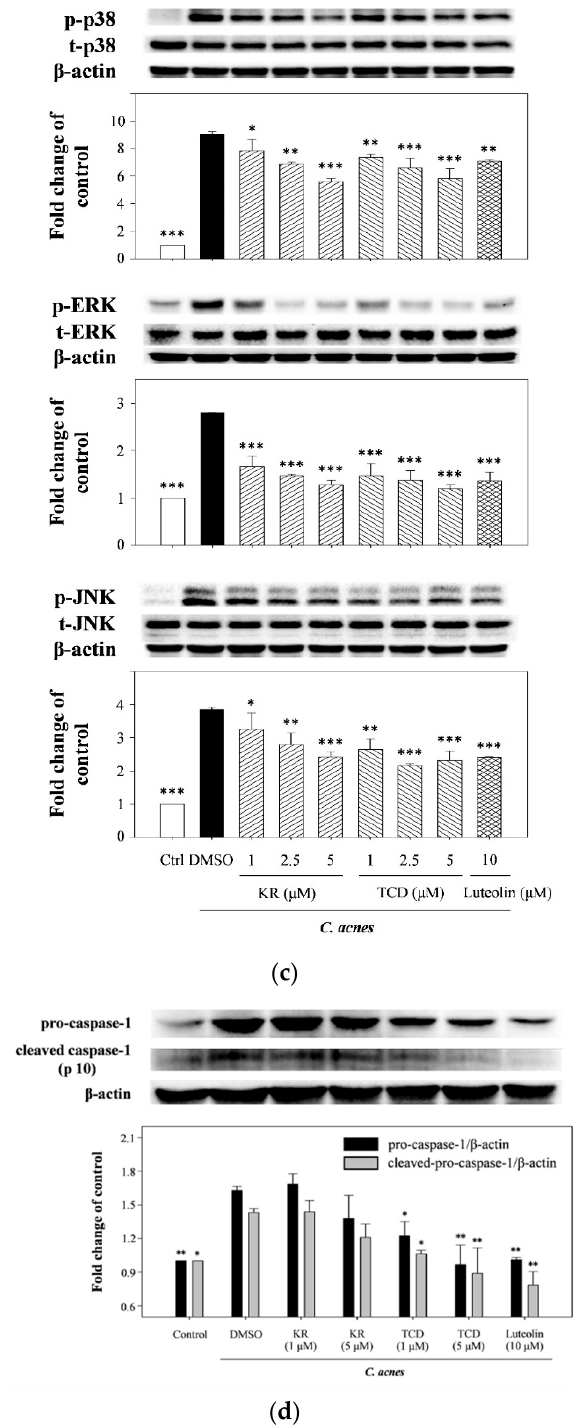
Figure 3. Effect of stimulation periods of C. acnes on activation of myeloid differentiation primary response 88 (MyD88) ( a ), and the effects of KR or TCD on MyD88 ( b ), mitogen-activated protein kinases (MAPK) ( c ), and on caspase-1 ( d ) expression. THP-1 cells were cultured with DMSO and co-incubated with C. acnes (M.O.I. = 75) for various periods of time (0, 10, 20, 30, 60, and 120 min) ( a ). To determine activation of MyD88, MAPK, and caspase-1, cells were cultured with DMSO as the negative control, or co-incubated with C. acnes (M.O.I. = 75) and different concentrations (1, 2.5 or 5 µ M) of KR or TCD for 20 min (for MyD88) ( b ), 2 h (for MAPK) ( c ), or 16 h (for caspase-1 expression activation) ( d ). Each value shows that the mean ± SD. Values with different symbols are significantly different from the C. acnes control ( C. acnes alone) at p < 0.05 (*), p < 0.01 (**), and p < 0.001 (***).